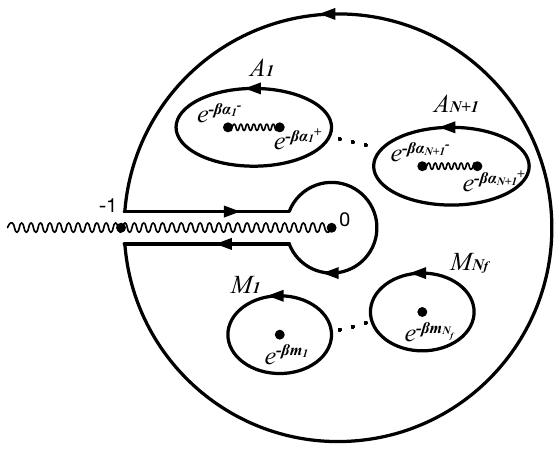
Figure 5 . Contour of the